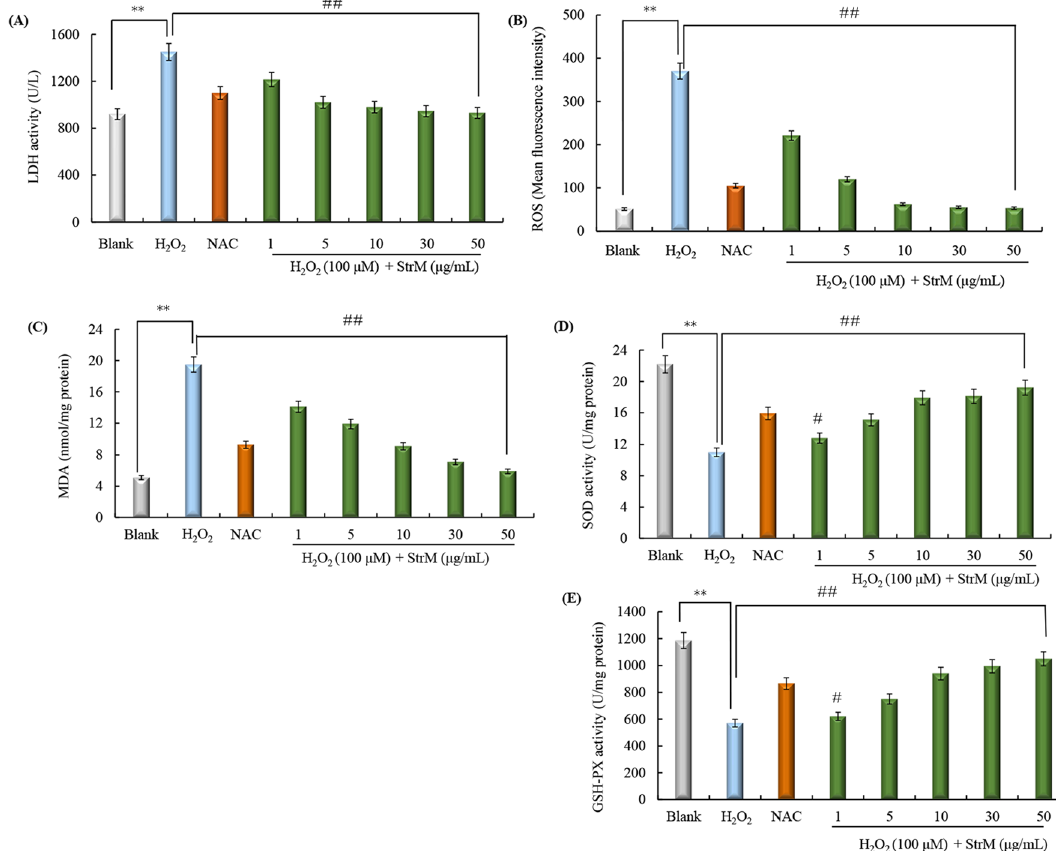
Figure 6. Effects of StrSM on LDH activity ( A ), intracellular ROS accumulation, ( C ) MDA content, ( D ) SOD, and ( E ) GSH-PX activity in SH-SY5Y cells. SH-SY5Y cells are pre-treated with different concentrations of StrSM (1, 5, 10, 30, and 50 μg/mL) for 5 h followed by co-treatment of 100 μM H 2 O 2 or 20 μM NAC for 24 h. The model group is only treated with 100 μM H 2 O 2 for 24 h. Data are presented as mean ± standard deviation of three independent experiments. ** p ≈ 0.006 < 0.01, # p ≈ 0.04 < 0.05, and ## p ≈ 0.005 < 0.01 are determined using one-way ANOVA and Dunnett post hoc test. NAC N -acetylcystein, StrSM melanin from Streptomyces sp.